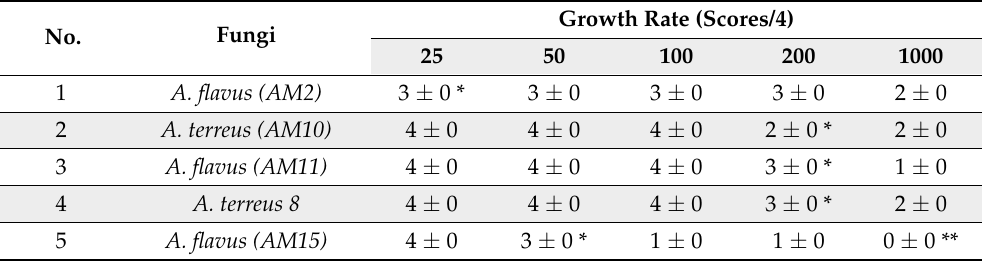
Table 9. Effect of different concentrations of AuNPs on fungal growth (growth rate score 0 = no growth, 4 = max growth) measured using broth microdilution